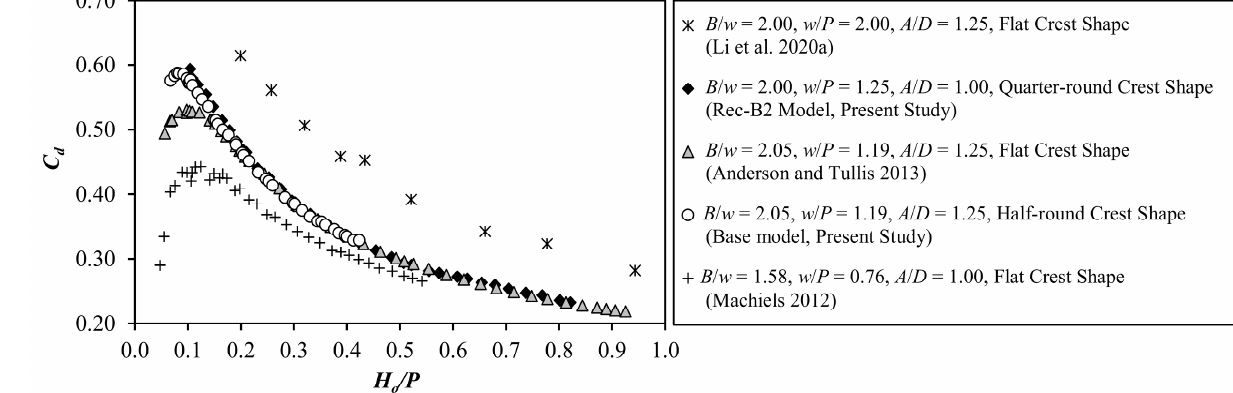
Figure 18. Comparison between the results of the present and previous studies (all geometries have a rectangular plan shape and identical overhang ratio of B i / B = B o / B = 0.25).